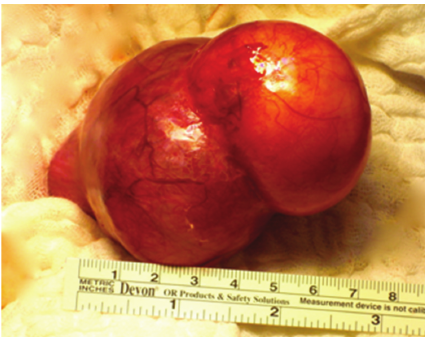
Figure 2: left dermoid cysts extracted from the abdominal cavity.